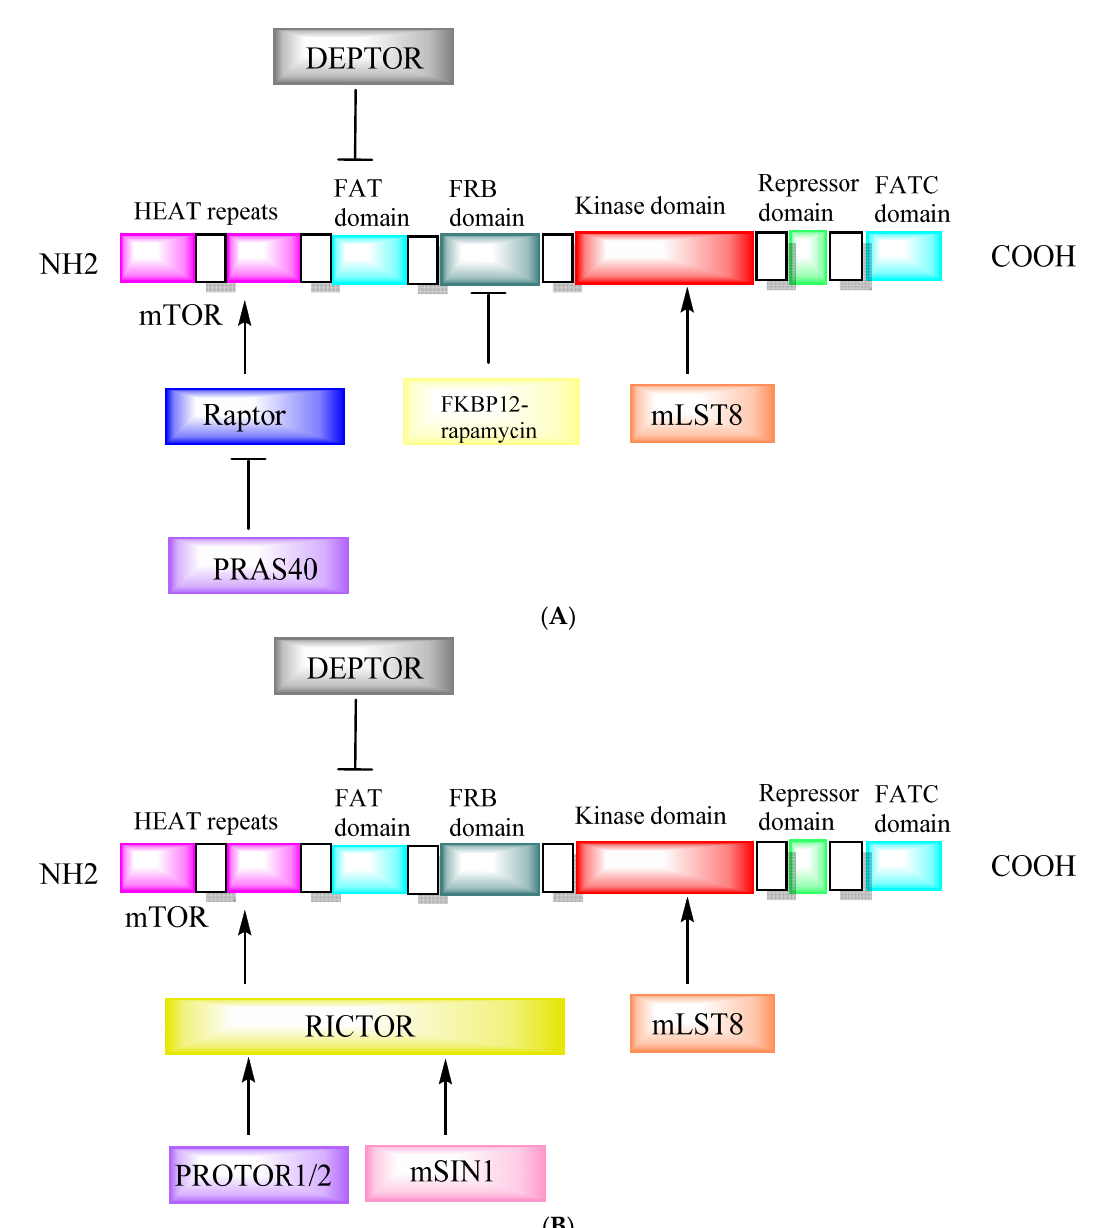
Figure 1. The structural domains of mTOR are shown hierarchically in this schematic. The HEAT domain, which is comprised of Huntingtin, elongation factor 3, subunit A of PP2A, and Tor1p; the FAT domain, which is comprised of FRAP-ATM-TRAPP; the FRB domain, which is comprised of FKBP12-rapamycin binding; and the FATC domain are the evolutionarily conserved structural domains of mTOR (FAT C-terminus). There are a total of 2549 amino acids found in the entire polypeptide sequence of mTOR. ( A ) Constituents of mTORC1: Important to the complex is the mTOR-interacting protein with the DEP domain (mLST8). The protein DEPTOR (mTOR-interacting protein) functions as an endogenous inhibitor of mTORC1. The mTOR-regulatory associated protein (Raptor), which has its own HEAT repeats and binds to mTOR, is the essential component of mTORC1. Moreover, in response to insulin, raptor recruits PRAS40, a proline-rich 40 kDa AKT substrate that suppresses mTORC1 activity. ( B ) mLST8, DEPTOR, and RICTOR, the defining component of mTORC2, are subunits of mTORC2. The rictor protein interacts with rictor-associated protein 1 and 2, which act as scaffolding proteins (RICTOR 1). Addition of PROTOR1/2, a pleckstrin homology domain-containing protein, and mSIN1, a MAPK interaction protein, to the